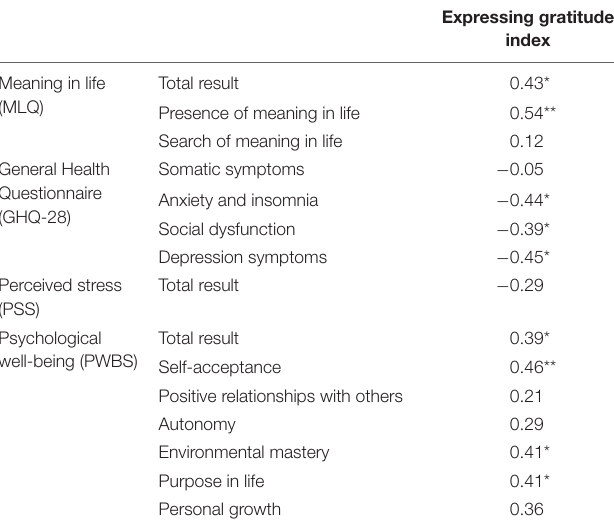
TABLE 4 | Spearman R correlations among expressing gratitude index and meaning in life, general health, perceived stress, psychological well-being ( n =